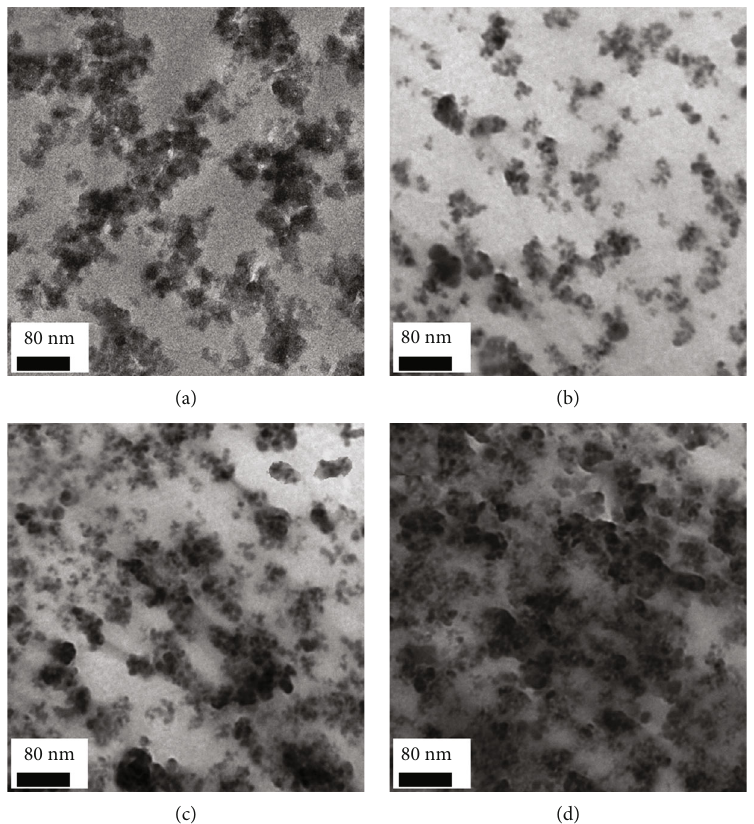
Figure 5: TEM images for nanosilica particles dispersed in epoxy nanocomposite. (a) Unmodi fi ed nanosilica content is 1phr, and alkyl- modi fi ed nanosilica contents are (b) 1phr, (c) 3phr, and (d)